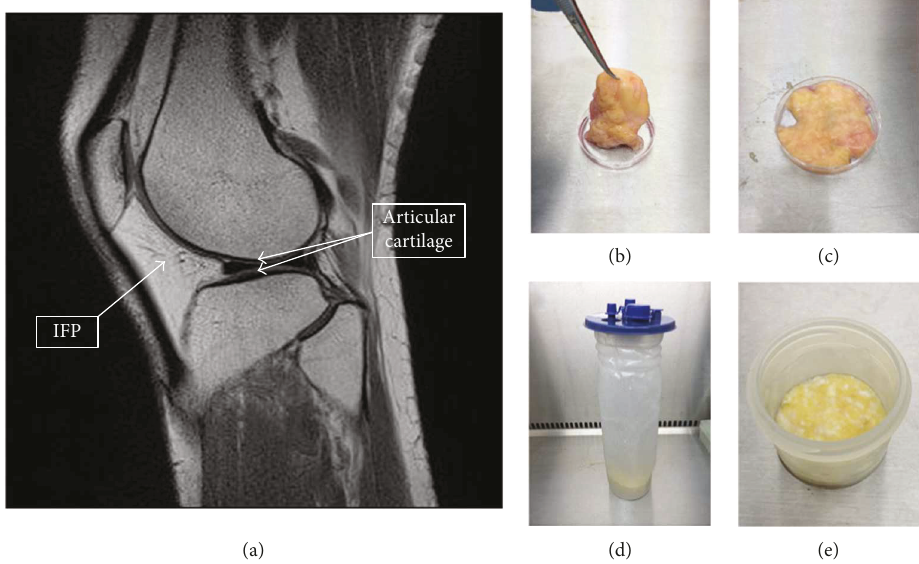
Figure 1: (Modi fi ed and used with permission from Wiley under CC BL). Infrapatellar fat pad (IFP) location and harvested tissue. (a) Sagittal magnetic resonance imaging scan of the knee showing the relationship of the IFP (arrow) to the articular cartilage (double arrow). (b, c) Excised IFP from a patient undergoing knee arthroplasty (b) has the fat removed from the fi brous tissue (c). (d, e) The arthroscopically harvested fat pad (d) was separated from the irrigation fl uid before enzymatic digestion